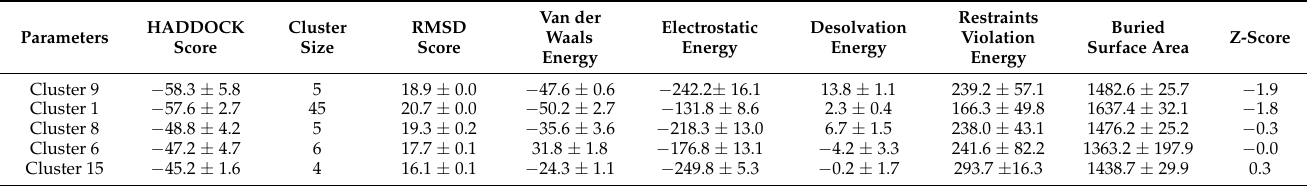
Table 1. Interaction energy and Binding energies of HIV-1RT (1C0T) docked with C-PC